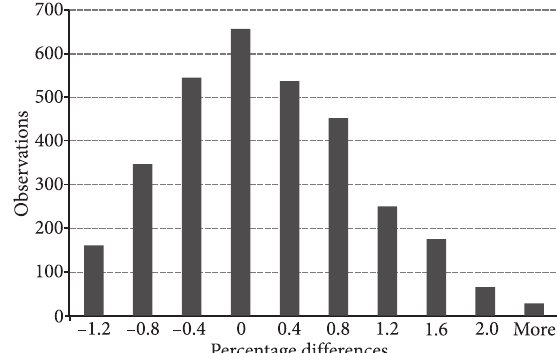
Fig. 10. Percentage differences between the observed and the predicted rut depth Table 5. Comparison of rut depth with values at different frequencies